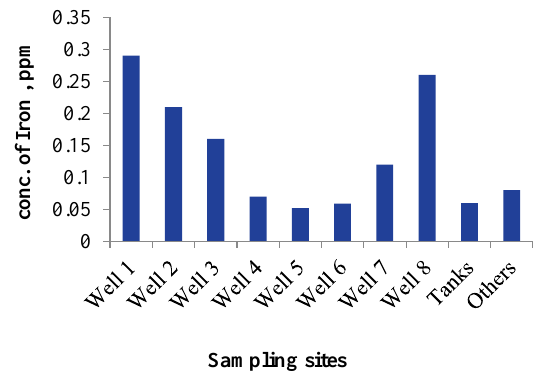
Figure 7. The average of Iron (mg/l) in well, Tanks and others